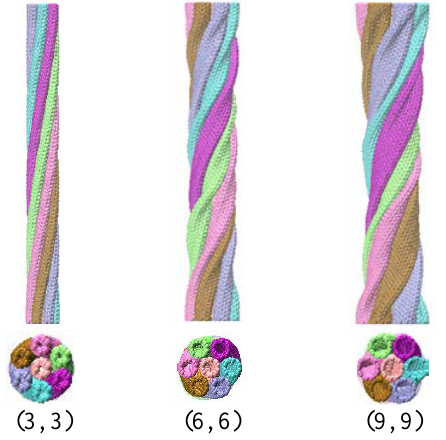
Figure 1. Nanoropes including carbon nanotubes (CNTs) with chiralities (3, 3) ( left ), (6, 6) ( middle ), and (9, 9) ( right ).